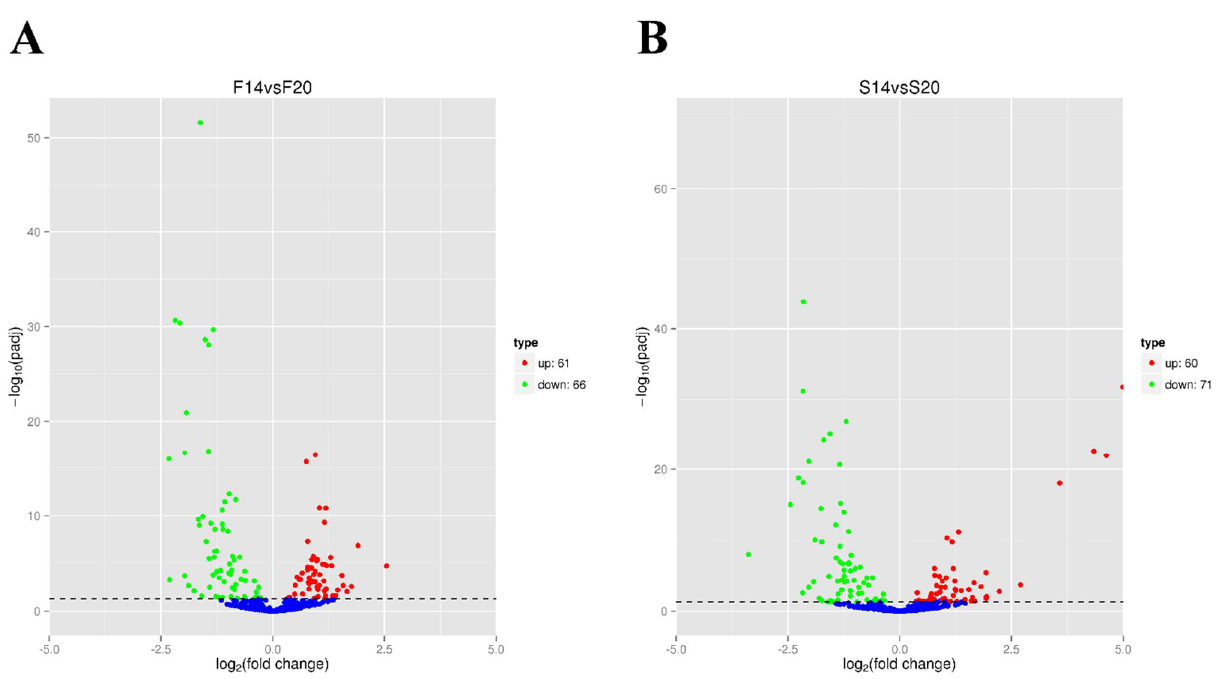
Figure 2. Volcano plot of differentially expressed miRNAs (DEMs). ( A ) Volcano plot of F14 vs. F20 comparison group; ( B ) volcano plot of S14 vs. S20 comparison group.